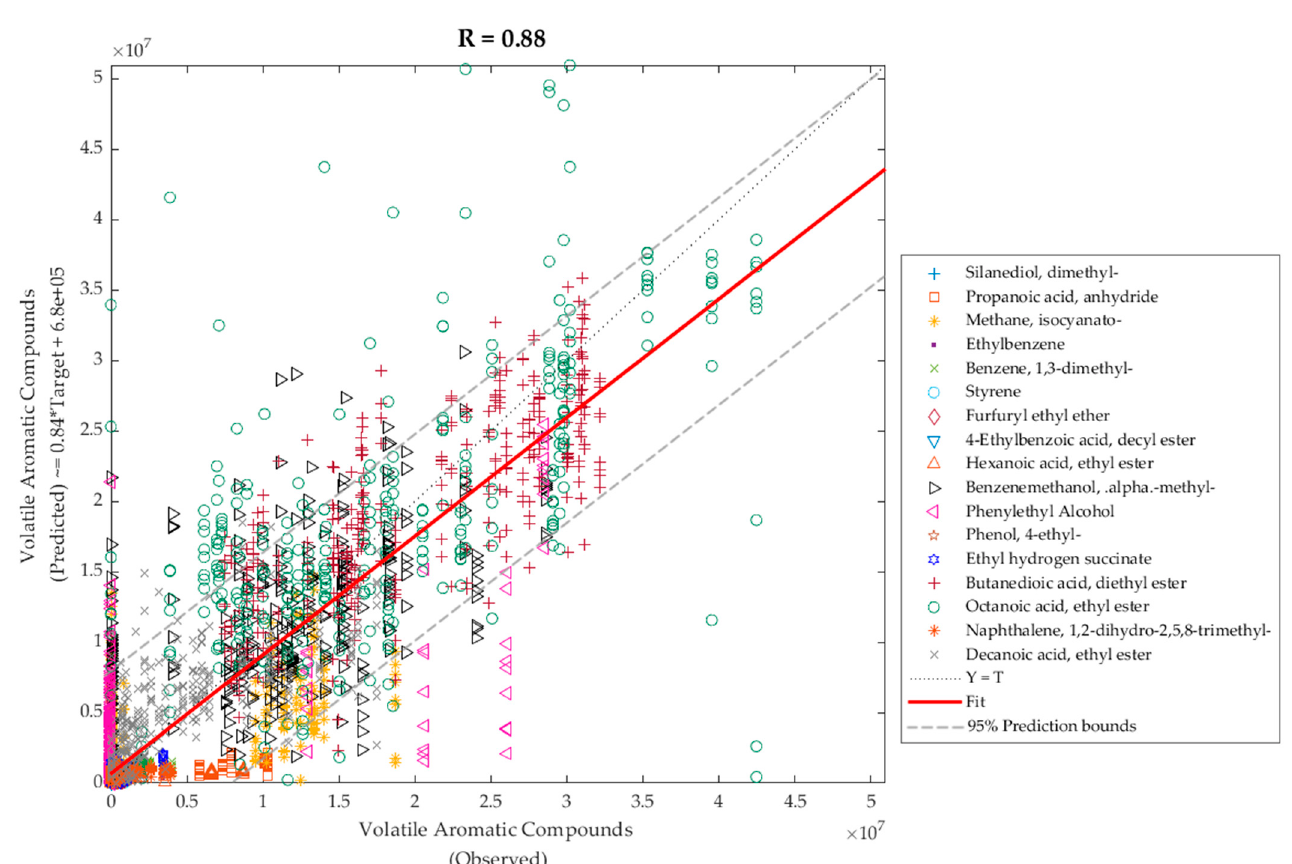
Figure 7. Overall machine learning model to predict volatile aromatic compounds using NIR ab- sorbance values measured through the bottles as inputs.